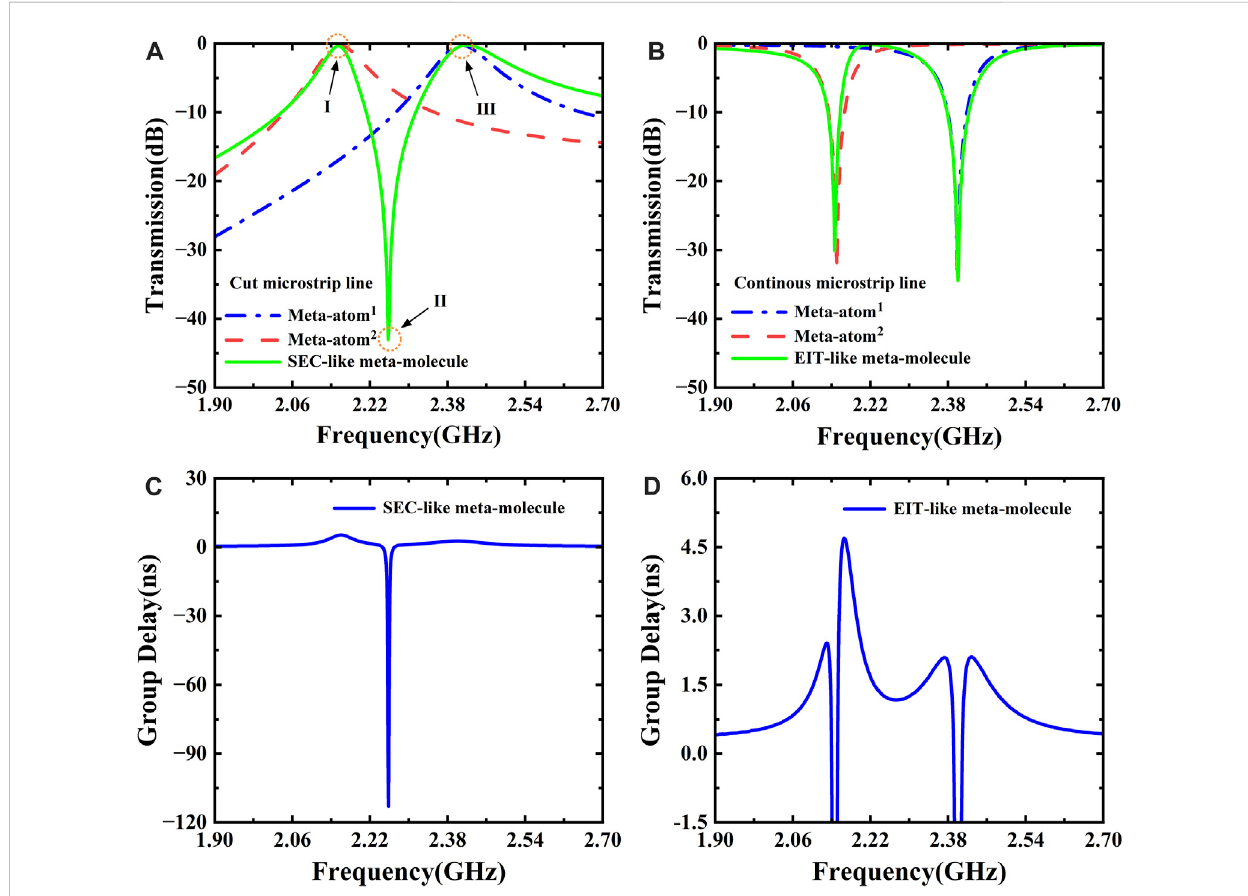
FIGURE 3 SimulatedtransmissionspectraoftheZIM-basedmeta-atomsandtherelatedcombinativemeta-moleculeina (A) cutand (B) continuousmicrostrip transmission line. The group delay of (C) SEC-like meta-molecule and (D) EIT-like